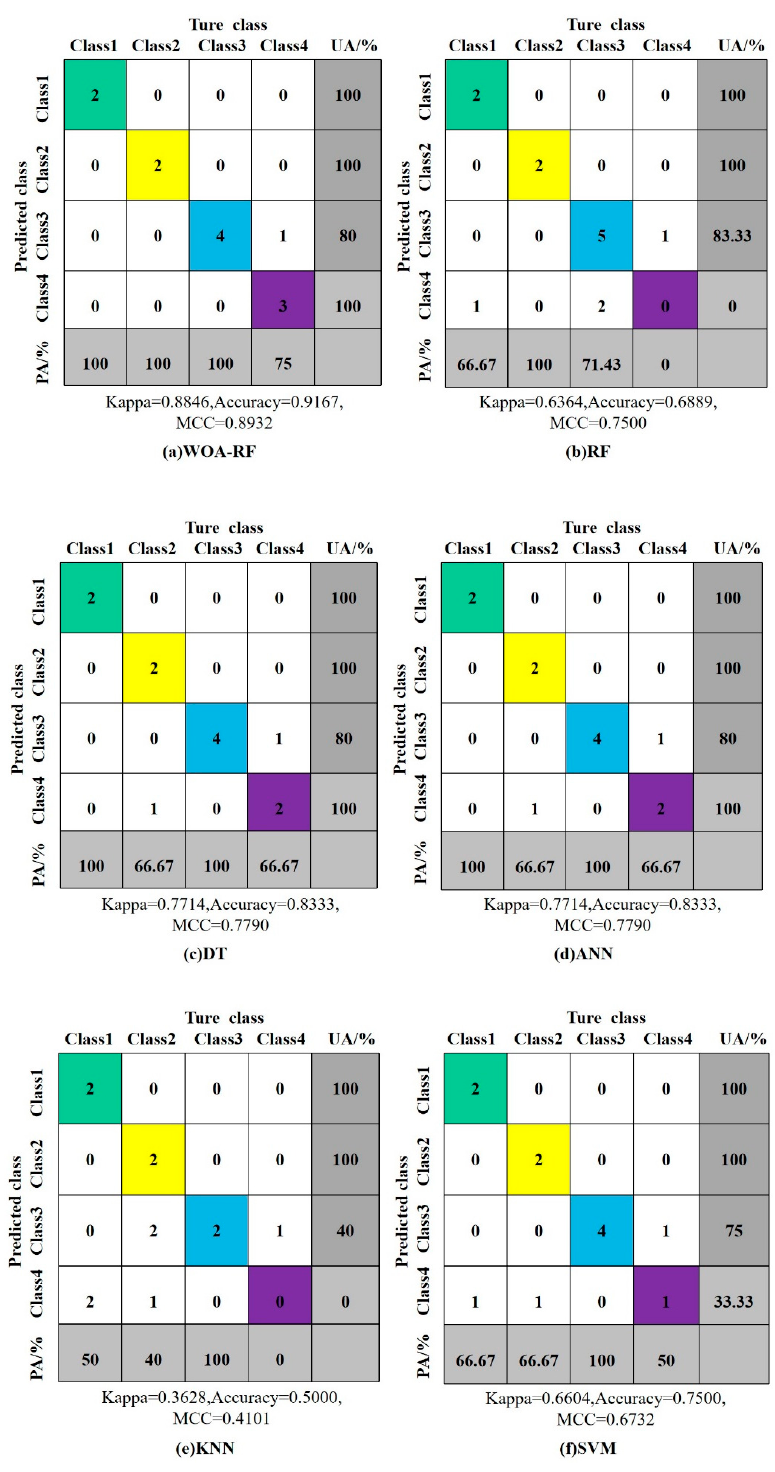
Figure 7. The confusion matrix. Figure 8 represents the actual and predicted classification results on the training and testing datasets. Fifty-nine samples of the training and testing datasets were on the hori- zontal axis. The training set was distributed with 47 samples and the testing set with 12 samples. The categories of the samples are presented on the vertical axis. Figure 8 shows the training set samples without error samples; testing set sample 55 with an actual cate- gory of 4, which was misclassified as a category of 3; and the training and testing datasets with error rates of 0 and 9.09%, respectively. However, many training and testing samples of the other five models were wrongly classified. Therefore, the WOA–RF hybrid model performs better and with higher accuracy in predicting the invalidation risk prediction of backfilling pipelines. Figure 8. The classification results on training and testing datasets of the WOA–RF model. The test performance of different classification models on the invalidation risk of a backfilling pipeline is listed in Table 3. According to Table 3, the WOA–RF model has